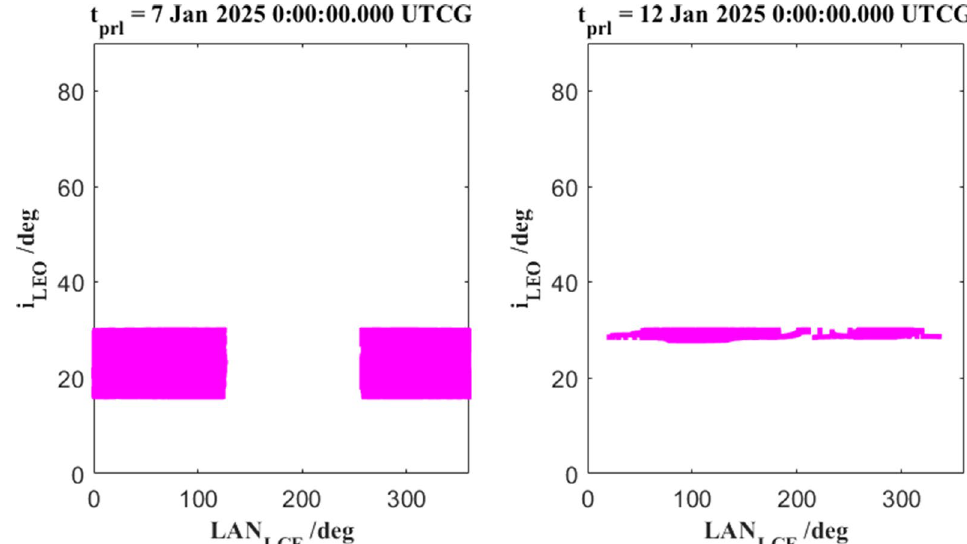
Fig. 12 The LEO inclination distributions when the lunar declination absolute value is the smallest and the